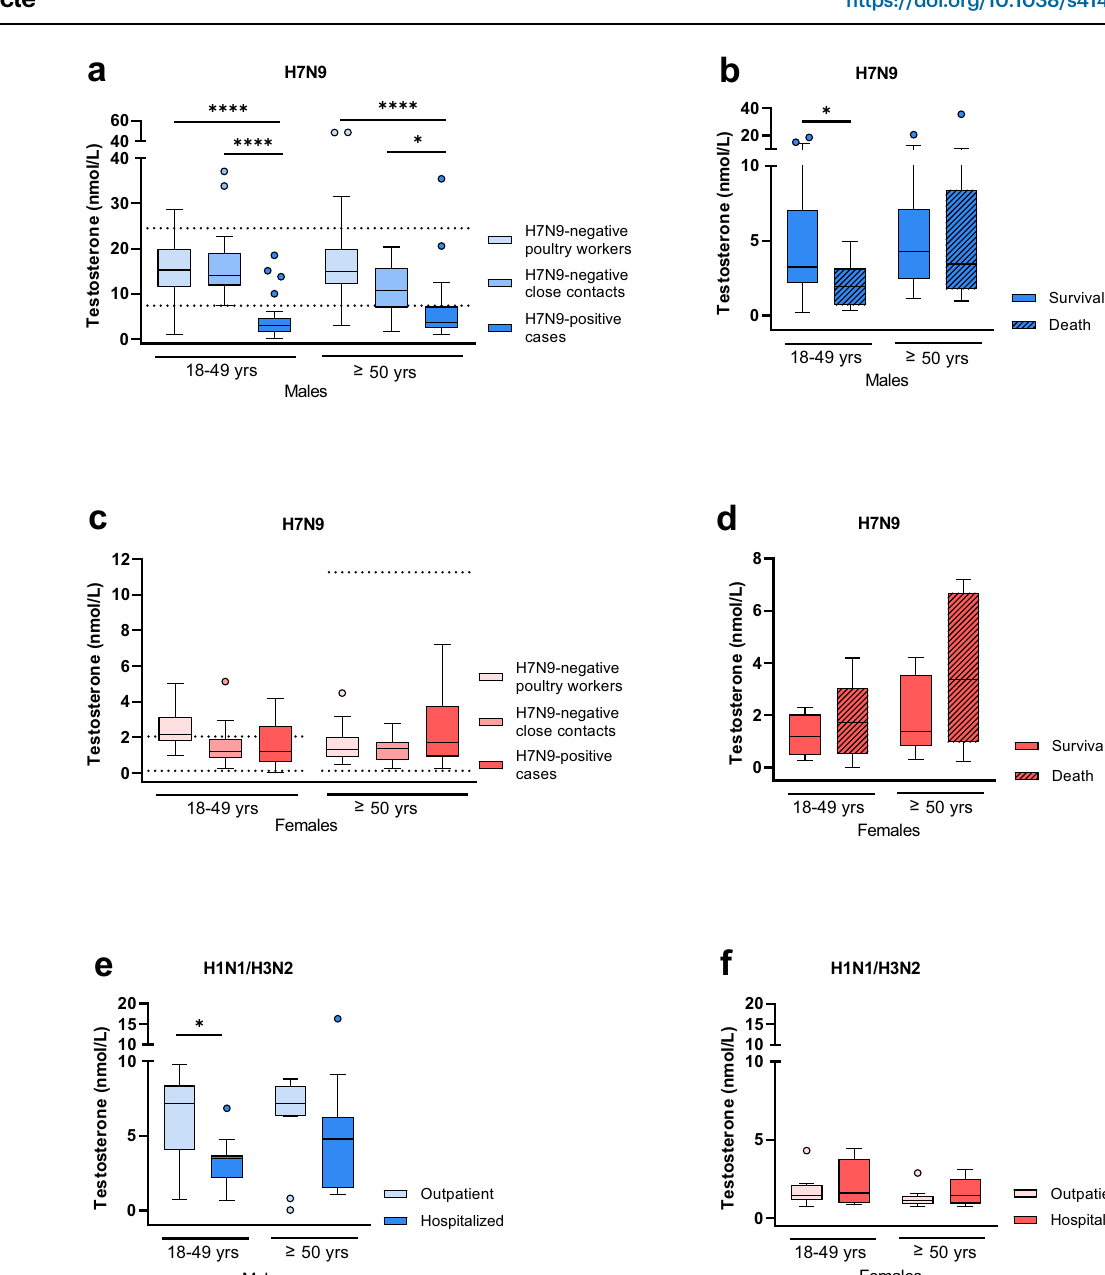
seasonal in fl uenza-infected male (18 – 49yrs outpatient/hospitalized: n =15/11, ≥ 50yrs outpatient/hospitalized: n =12/14) ( e ) and female patients (18 – 49yrs out- patient/hospitalized: n =12/4, ≥ 50yrs outpatient/hospitalized: n =13/10) ( f ) and compared in dependency of disease severity (outpatient vs. hospitalized). a , c The age-speci fi creferencerangeoftestosteroneinChinesemenandwomenwasadded as dotted lines in ( a ) and ( c ) (no age difference in testosterone in Chinese men) 14 . a – f Data are presented as Box-and-whisker plots (Tukey). The horizontal line in each box represents the median value. The 25th – 75th percentiles represent the endpoints of the box. The whiskers stretchto the lowest and highest values within 1.5 times the interquartile range (IQR) from the 25th – 75th percentiles. Dots represent outliers according to Tukey ’ s de fi nition. Unpaired, two-tailed non-para- metric analysis (Mann ‒ Whitney test) was used for comparisons between two groups ( b , d , e , f ). The Kruskal ‒ Wallis test ( a , c ) was used for comparisons among the three groups. P values were classi fi ed into four groups: * p <0.05, ** p